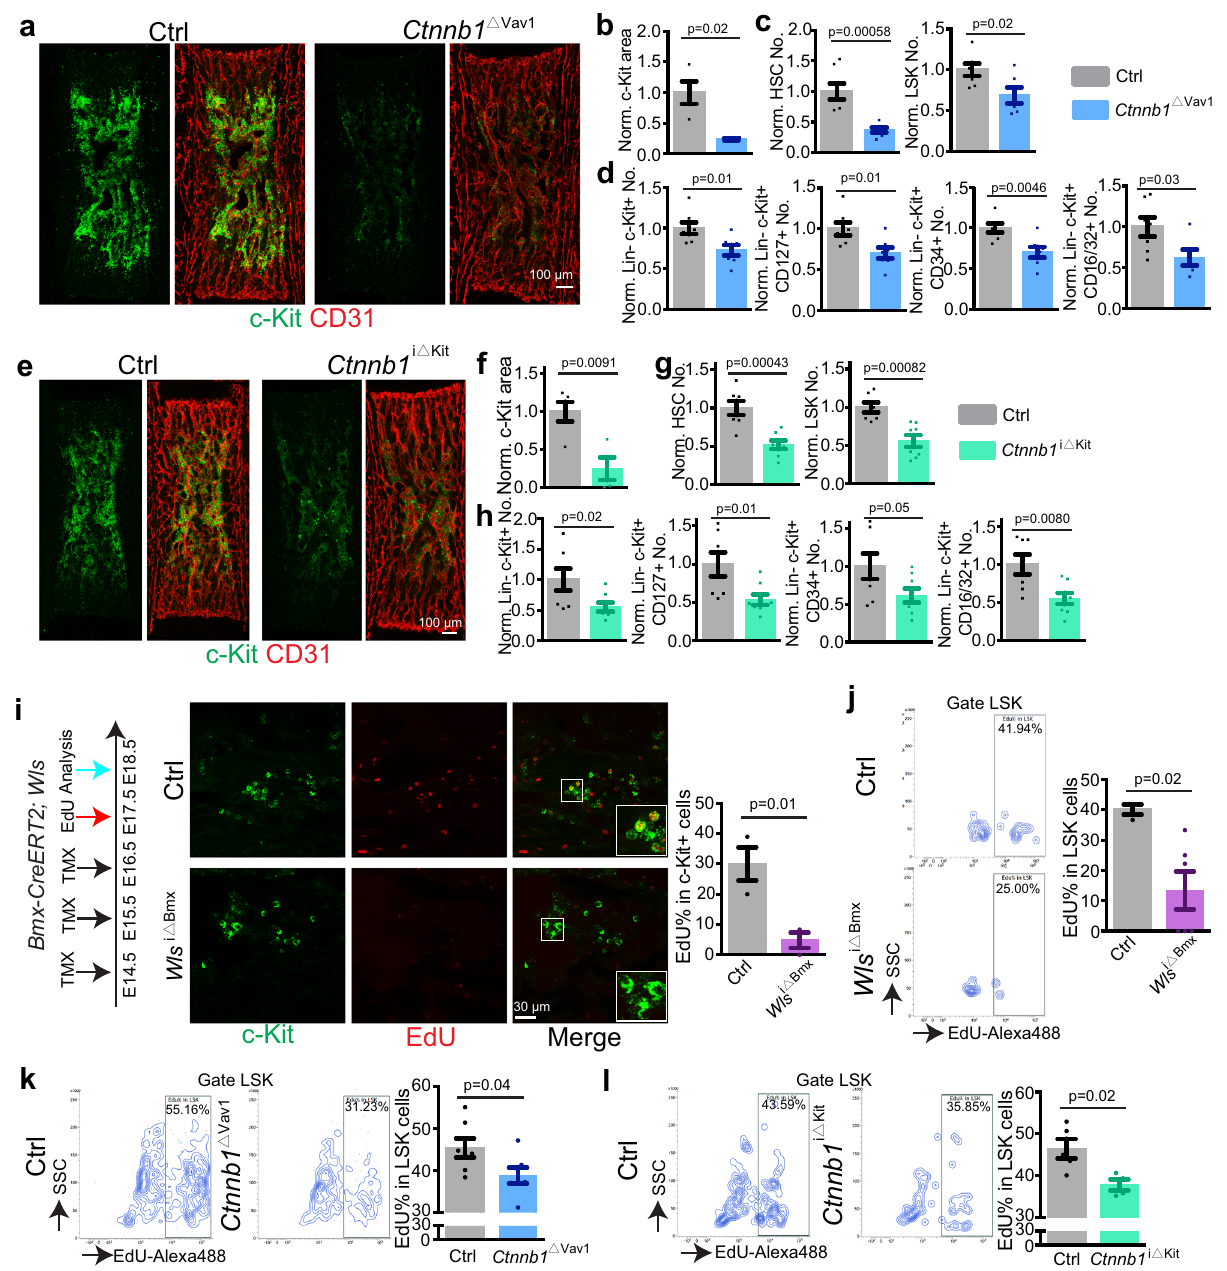
Fig. 6 AECs regulate HSPC proliferation through Wnt and β -catenin. a Overview images showing c-Kit + cell covered area in Ctnnb1 Δ Vav1 knockout and littermate control BM at E18.5. b Quanti fi cation of c-Kit + cell covered area (Ctrl = 4; Ctnnb1 Δ Vav1 = 4). Error bars, mean ± s.e.m. Two-tailed Student ’ s t test. c , d FACS-based quanti fi cation of normalized HSC and LSK cells ( c ) and of Lin − c-Kit + , Lin − c-Kit + CD127 + , Lin − c-Kit + CD34 + , Lin − c-Kit + CD16/32 + cells in Ctnnb1 Δ Vav1 and littermate controls at E18.5 ( c ). Ctrl = 7; Ctnnb1 Δ Vav1 = 7. Absolute cell numbers were normalized to control. Error bars, mean ± s.e.m. Two-tailed Student ’ s t test. e Representative overview images of c-Kit + cell covered area in Ctnnb1 i Δ Kit and littermate control BM at E18.5. f Quanti fi cation of c-Kit + cell covered area. Ctrl = 5; Ctnnb1 i Δ Kit = 4. Error bars, mean ± s.e.m. Two-tailed Student ’ s t test. g , h FACS-based quanti fi cation of normalized HSC and LSK cells ( g ) and of Lin − c-Kit + , Lin − c-Kit + CD127 + , Lin − c-Kit + CD34 + , Lin − c-Kit + CD16/32 + cells ( h ) in Ctnnb1 i Δ Kit mutants and littermate controls at E18.5. Ctrl = 7; Ctnnb1 i Δ Kit = 8. Absolute cell numbers were normalized to control. Error bars, mean ± s.e.m. Two-tailed Student ’ s t test. i Diagram showing tamoxifen injection, EdU injection and analysis of Wls i Δ Bmx mutants. High magni fi cation single plane images showing EdU labeling of c-Kit + cells. Image-based quanti fi cation of EdU% in c-Kit + cells. Ctrl = 3; Wls i Δ Bmx = 3. Error bars, mean ± s.e.m. Two-tailed Student ’ s t test. j Representative FACS plot showing EdU incorporation into Wls i Δ Bmx and control LSK cells. FACS based quanti fi cation of EdU% in Wls i Δ Bmx ( N = 6) and control ( N = 3) LSK cells. Error bars, mean ± s.e.m. Two-tailed Student ’ s t test. k FACS plot showing EdU incorporation into Ctnnb1 Δ Vav1 and control LSK cells. Quanti fi cation of EdU% in LSK cells. Ctrl = 7; Ctnnb1 Δ Vav1 = 7. Error bars, mean ± s.e.m. Two-tailed Student ’ s t test. l FACS plot showing EdU incorporation into Ctnnb1 i Δ Kit and control LSK cells. Quanti fi cation of EdU% in LSK cells. Ctrl = 5; Ctnnb1 i Δ Kit = 4. Error bars, mean ± s.e.m. Two-tailed Student ’ s t